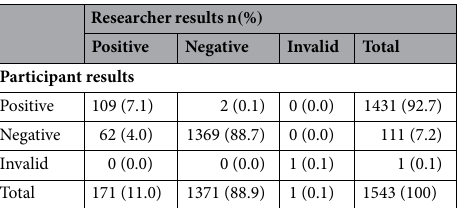
Table 9. Results based on self-test in cars interpreted by the participants and the researchers. The values in the brackets show the percentage of the results related to total number of results